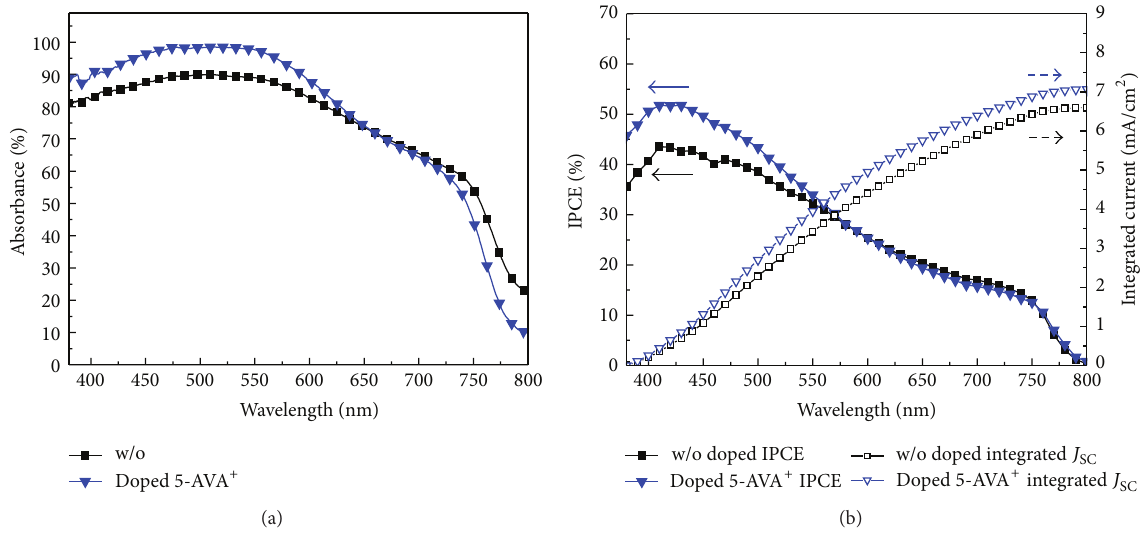
Figure 8: (a) The UV-vis spectra of FTO glass/cp-TiO 2 /mp-TiO 2 films filling with MAPbI 3 (black) and (5-AVA ) 𝑥 ( MA ) 1−𝑥 PbI 3 (blue). (b) The IPCE curves and corresponding integrated photocurrent curves of the devices with/without doping 5-AVA + .